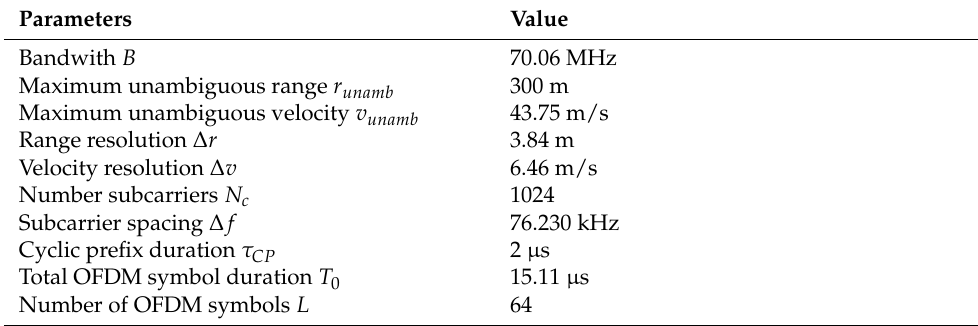
Table 1. OFDM and design criteria parameters for ISAC system.